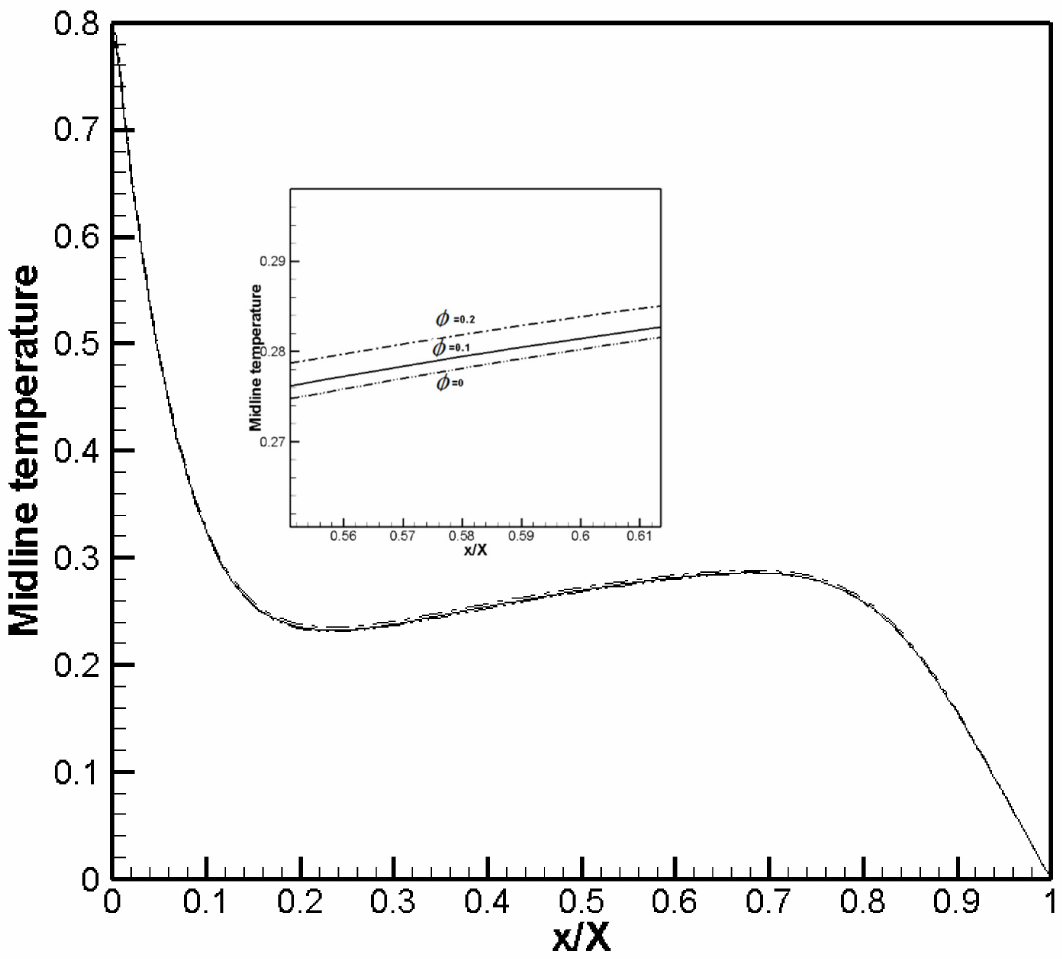
Figure 5. Non-dimensional temperature in axial midline versus x position for different volume fractions ( φ ) for Ra = 10 5